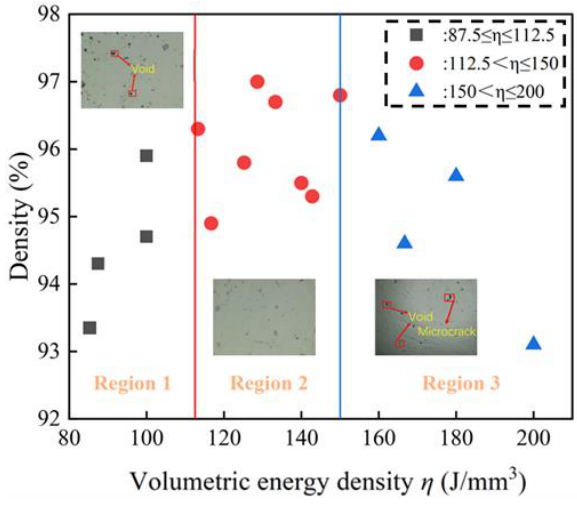
Figure 3. Relationship between density and the volumetric energy